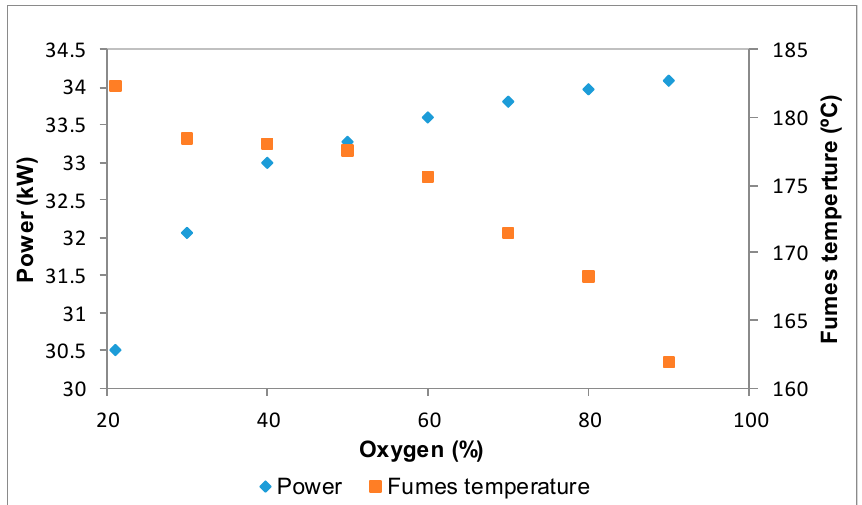
Figure 10. Effect of the oxygen enrichment in the power transferred to water and fumes temperature.